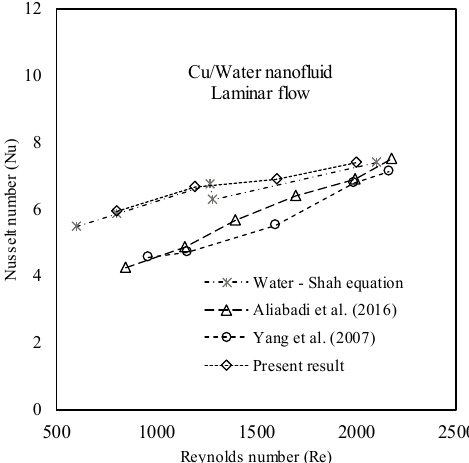
Figure 7. Validation of the present results with the existing literature. It is noted that for both laminar and turbulent flow regimes, the Nu value for TiO 2- water nanofluid is lesser when compared with Cu-water nanofluid. The thermal conductivity of metallic nanoparticles is much higher than the metallic oxide nanoparticles [26]. Due to this, the effective thermal conductivity increases and thereby enhances the value of Nu. In addition, the validation of Nu is carried out with previously published works particularly for laminar flow. Based on the vali- dation, the numerical results of Nu for Cu/water nanofluid obtained from the present study agrees well with Aliabadi et al. [27] and Yang et al. [28] with the average deviation of 11.2 and 13.1%, respectively. However, in case of metallic nanofluids, the stability of nanoparticles must also be focused upon as settlement occurs due to its higher density.